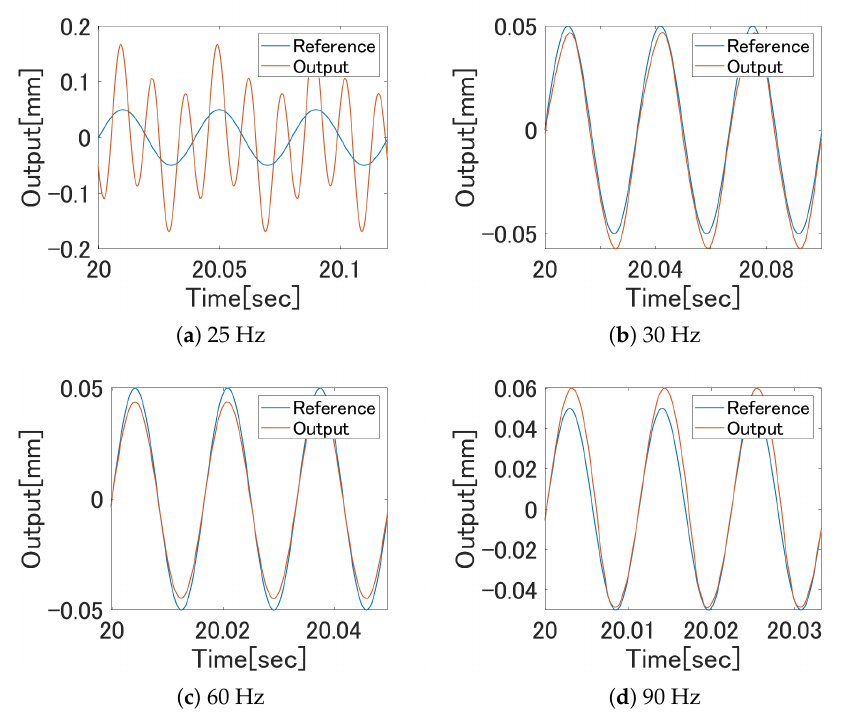
Figure 18. Time domain plots of the reference and the corresponding actuator